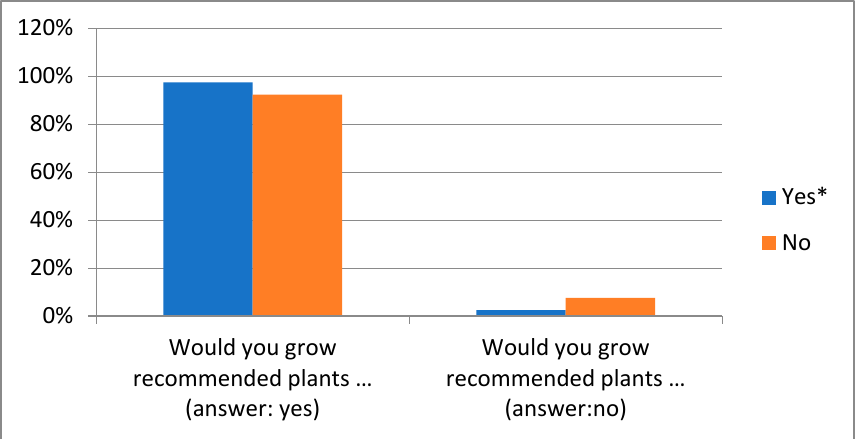
Figure 6. Graphic presentation of dependence of two variables: pointing SD as important SC factor and growing recommended plants to expand green areas in the city. Source: own elaboration. * Recognizing SD as important SC factor.